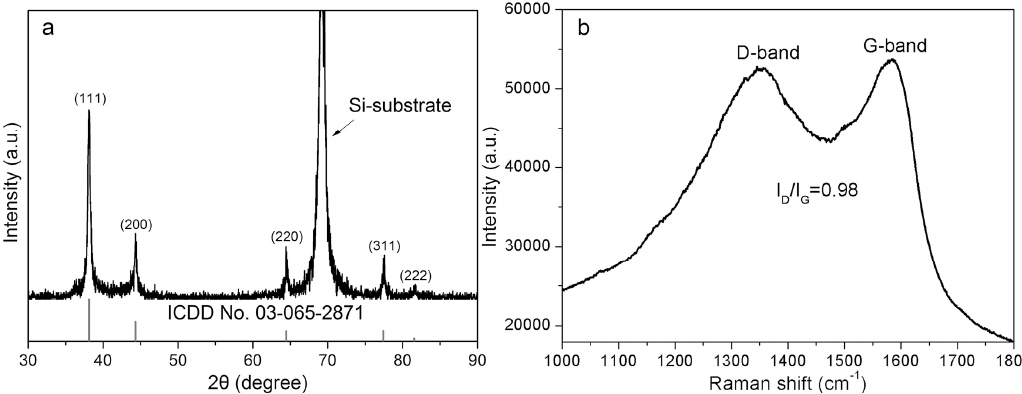
Figure 5. ( a ) XRD pattern and ( b ) Raman spectrum of the LAL-synthesized Ag NPs.